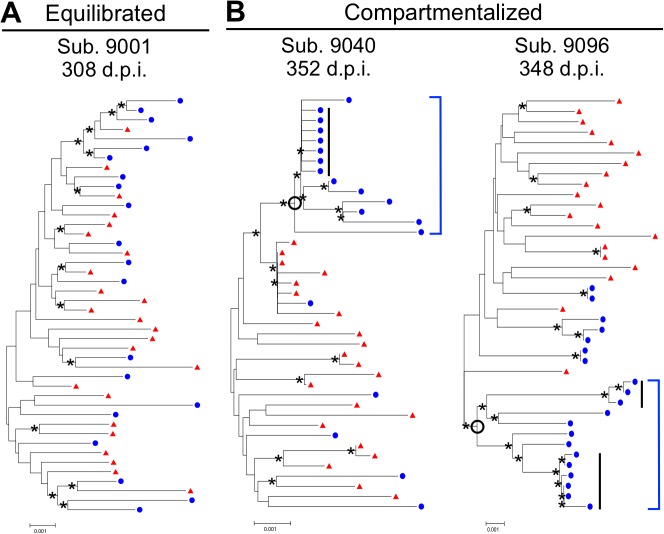
HIV-1 blood and CSF populations early during infection can be equilibrated or compartmentalized.Neighbor-joining phylogenetic trees depicting sequence relationships from subjects with (A) equilibrated and (B) compartmentalized viral populations. env sequences from the CSF (blue circles) and blood plasma (red triangles) are shown. Bootstrap values ≥35 are included (*) at the appropriate nodes. Genetic distance is indicated at the bottom of each figure (0.001, number of nucleotide substitutions per site between env sequences). Compartmentalized CNS populations are designated by an open circle at the appropriate node and a solid blue bracket. Clonal amplification is indicated by a solid black bar.